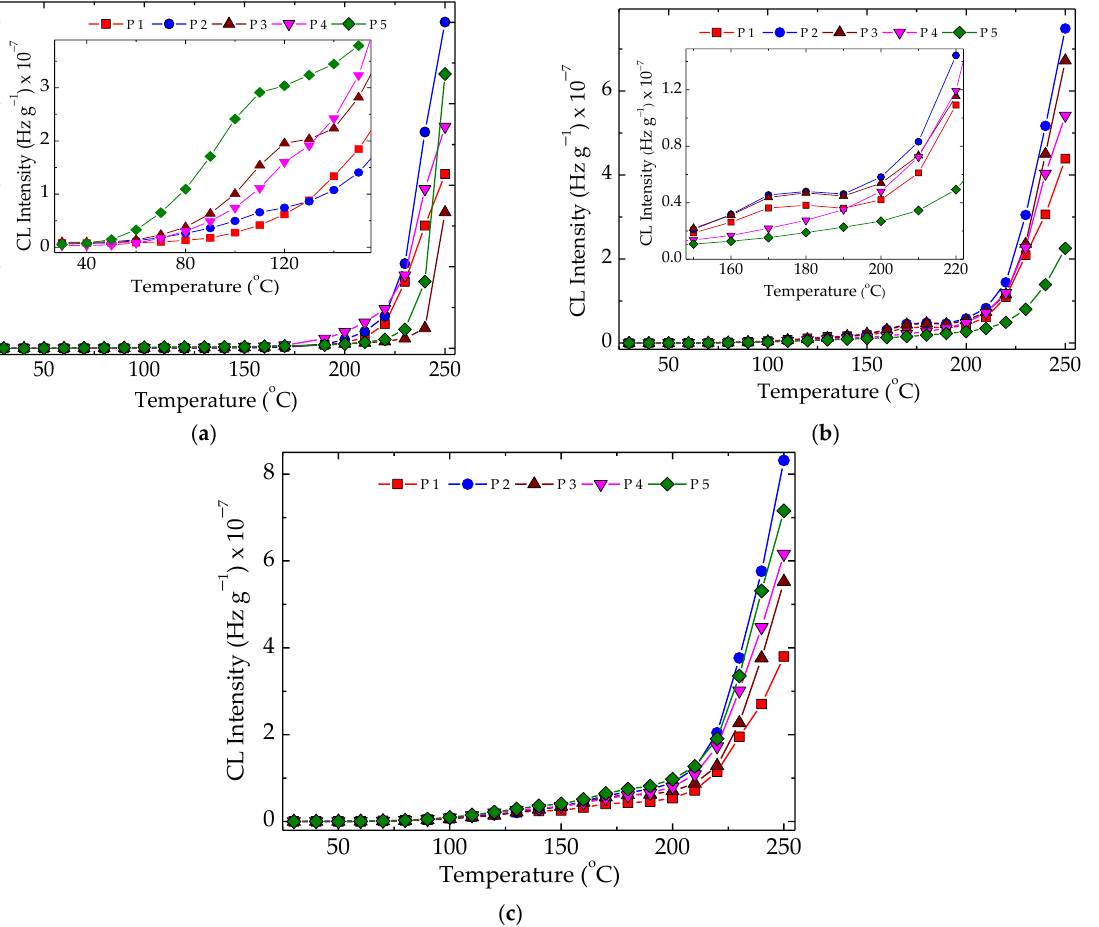
Figure 5. Nonisothermal CL spectra recorded for various compositions of LDPE/UHMWPE probes subjected to the action of γ -radiation. (P1) LDPE/UHMWPE; (P2) LDPE/HAp; (P3) LDPE/HAp/RM; (P4) LDPE/UHMWPE/HAp; (P5) LDPE/UHMWPE/HAp/RM. Exposure doses: ( a ) 0 kGy; ( b ) 50 kGy; ( c ) 100 kGy. Heating rate: 10 °C min −1 .